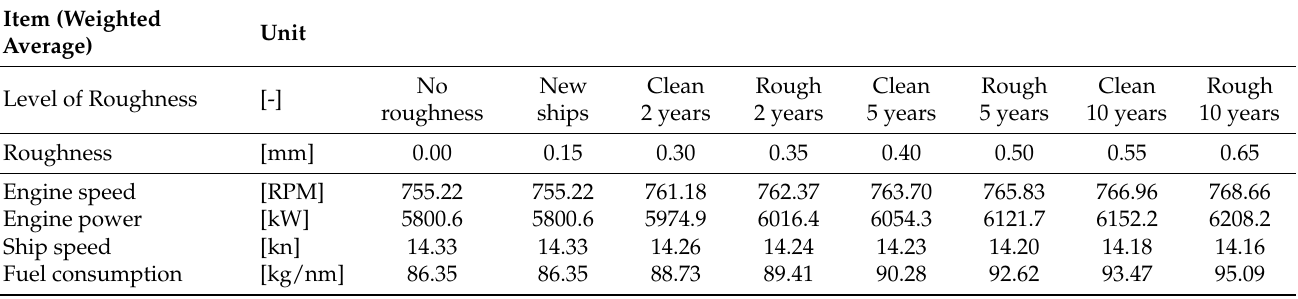
Table A2. Comparison of the weighted average results for different roughness along the